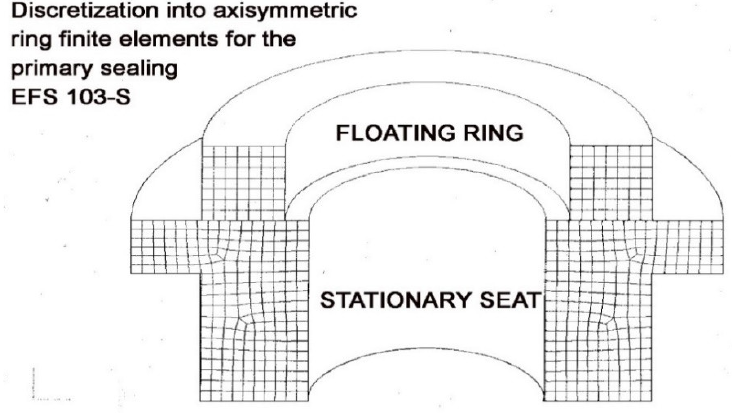
Figure 6. Finite element discretization [31].